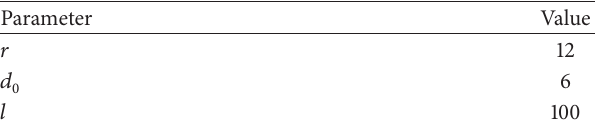
Table 3 contains parameter values for the WPA